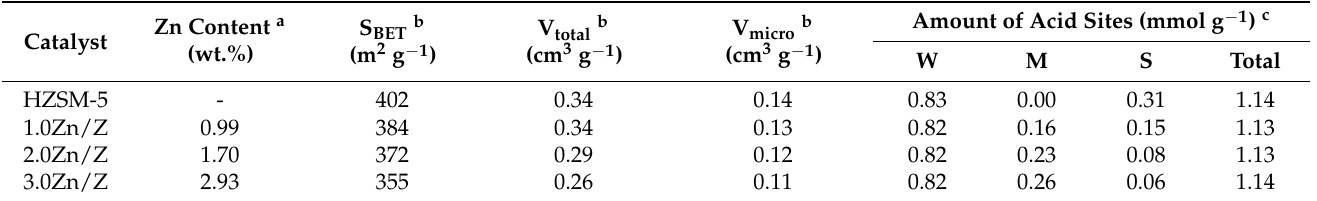
Table 1. Zn content, texture properties and acidities of 1.0Zn/Z, 2.0Zn/Z and 3.0Zn/Z. Catalyst